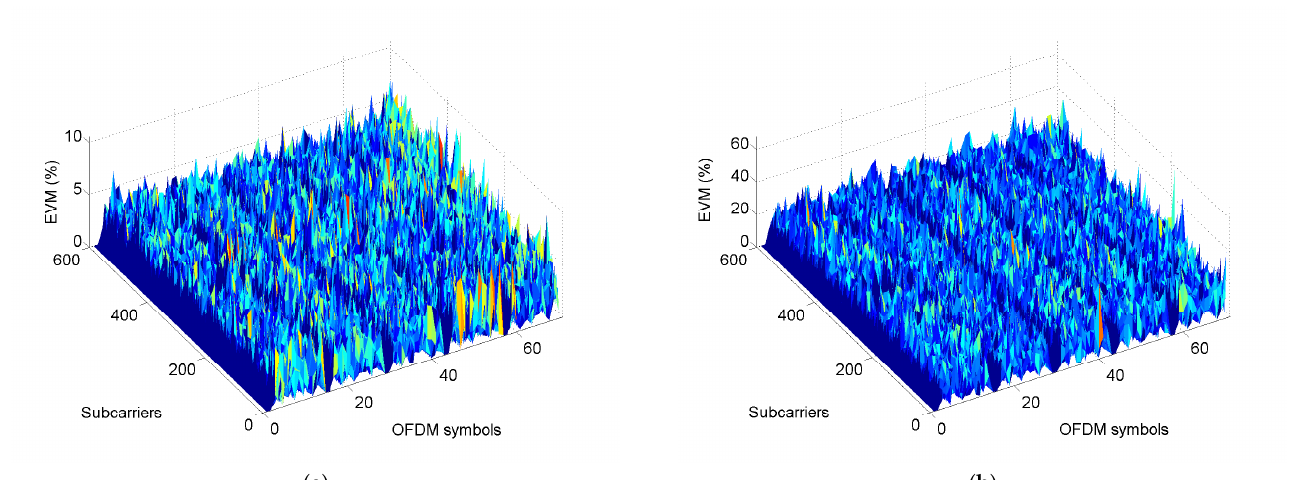
Figure 7. EVM (%) for the input and output signal, before and after applying a scale factor: ( a ) actual 64–QAM 10–MHz signal, and ( b ) receiver